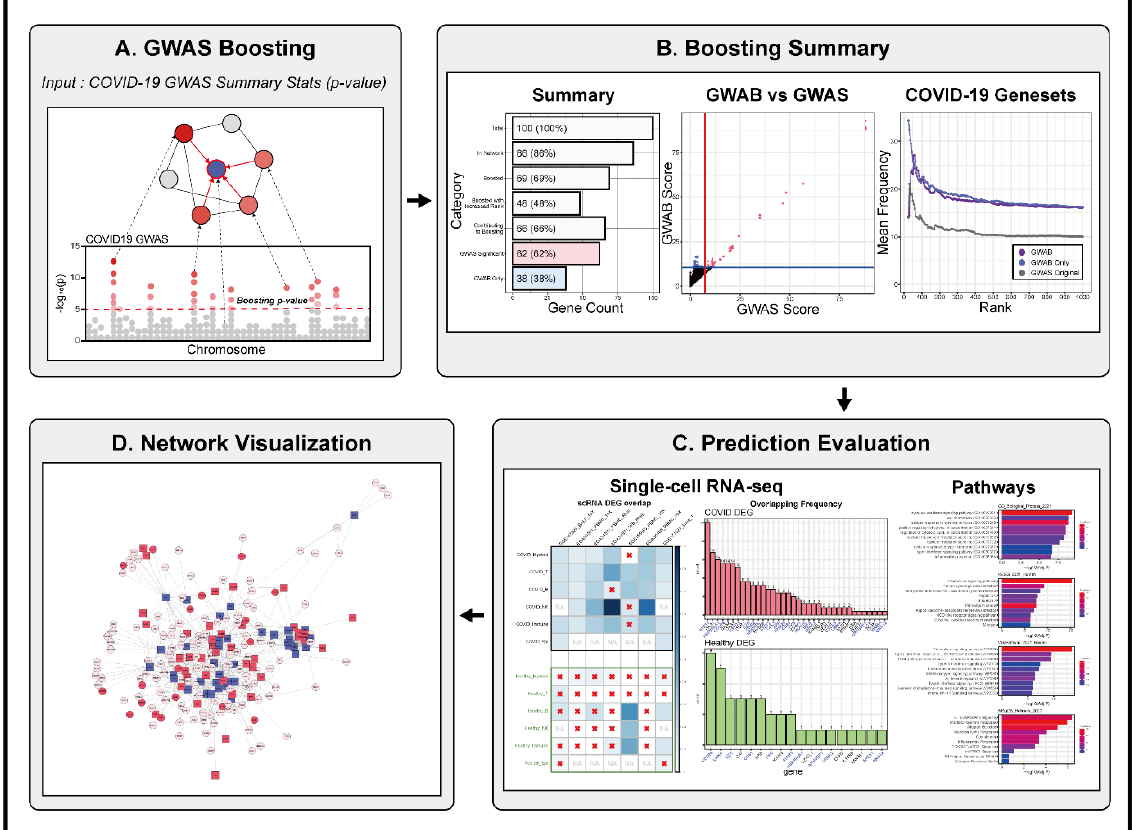
Figure 1. Overview of COVID-GWAB. ( A ) Graphical summary of the method for the network boosting of GWAS data, ( B – D ) Representative web interfaces for summary reports of the network boosting ( B ), prediction evaluation ( C ), and visualizing a candidate gene network ( D ). A red × in ( C ) indicates no significant overlap for the corresponding categories ( p > 0.05, Fisher’s exact